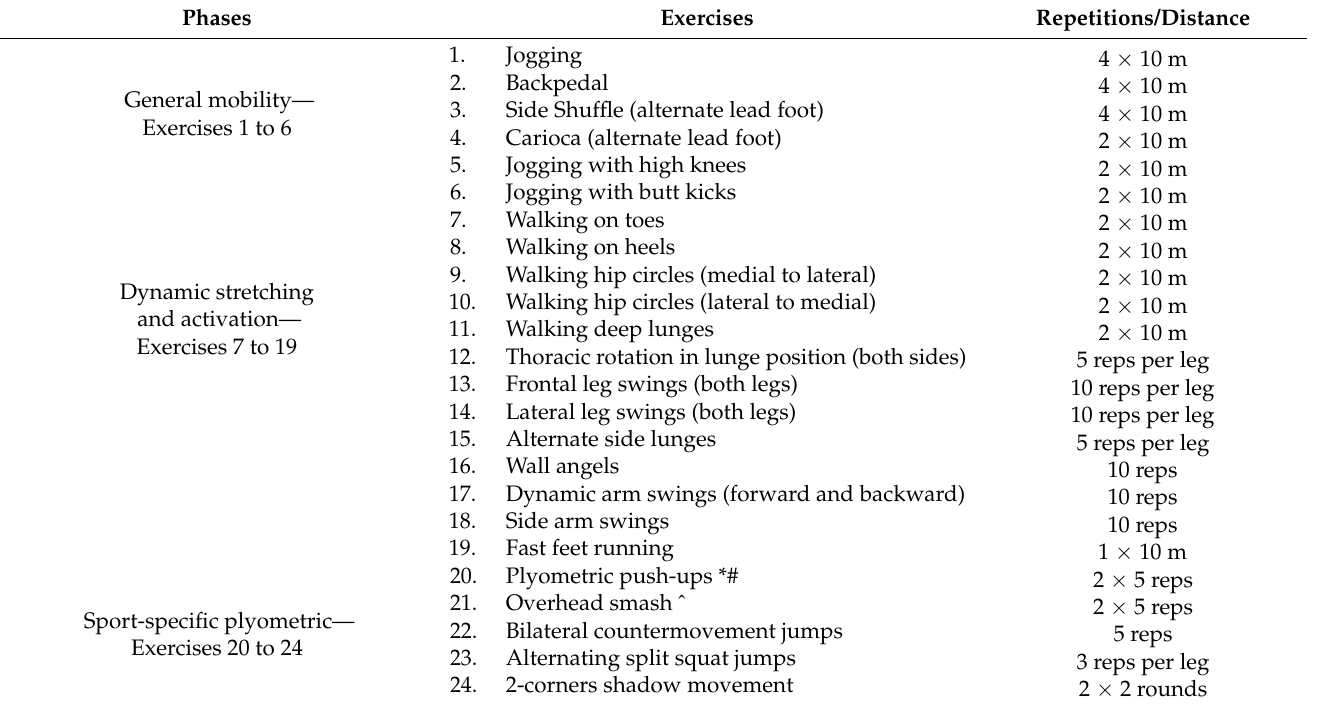
Table 1. Exercises involved in the 3 different warm-ups of control (CON), weighted wearable resistance (WWR), and banded variable resistance (BVR). Exercises